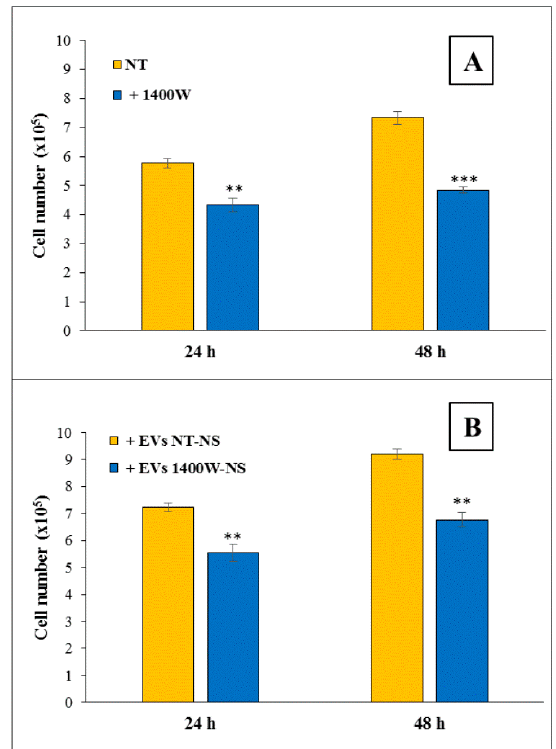
Figure 6. Proliferation assay of adherent U87MG cells treated with 1400W or EVs released by NT-NS